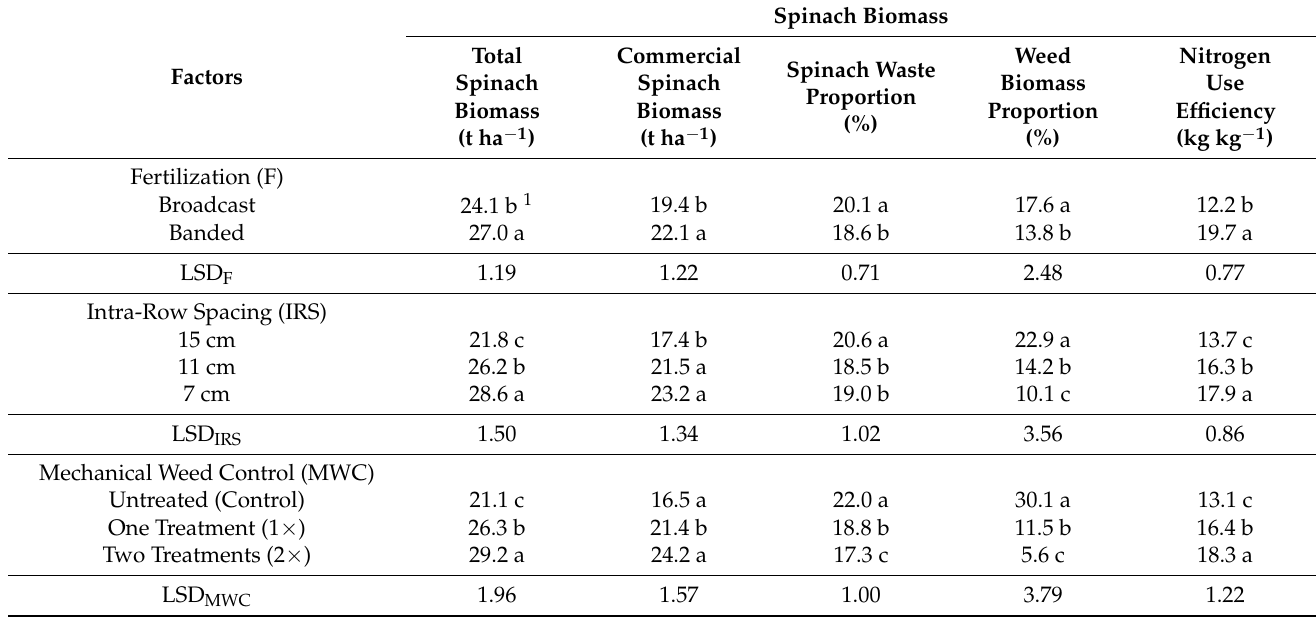
Table 5. Total spinach biomass (t ha − 1 ), commercial spinach biomass (t ha − 1 ), spinach waste proportion (%), weed biomass proportion (%), and nitrogen use efficiency (kg kg − 1 ) data obtained for each experimental factor. Means were separated according to Fischer’s Least Significance Difference (LSD) test ( a = 0.05).